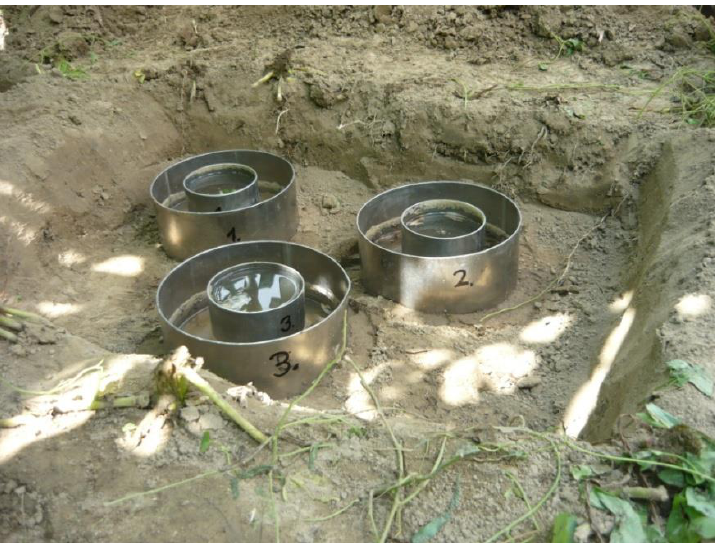
Figure 2. The double-ring infiltrometer (DRI) (photo. Ł. Borek).